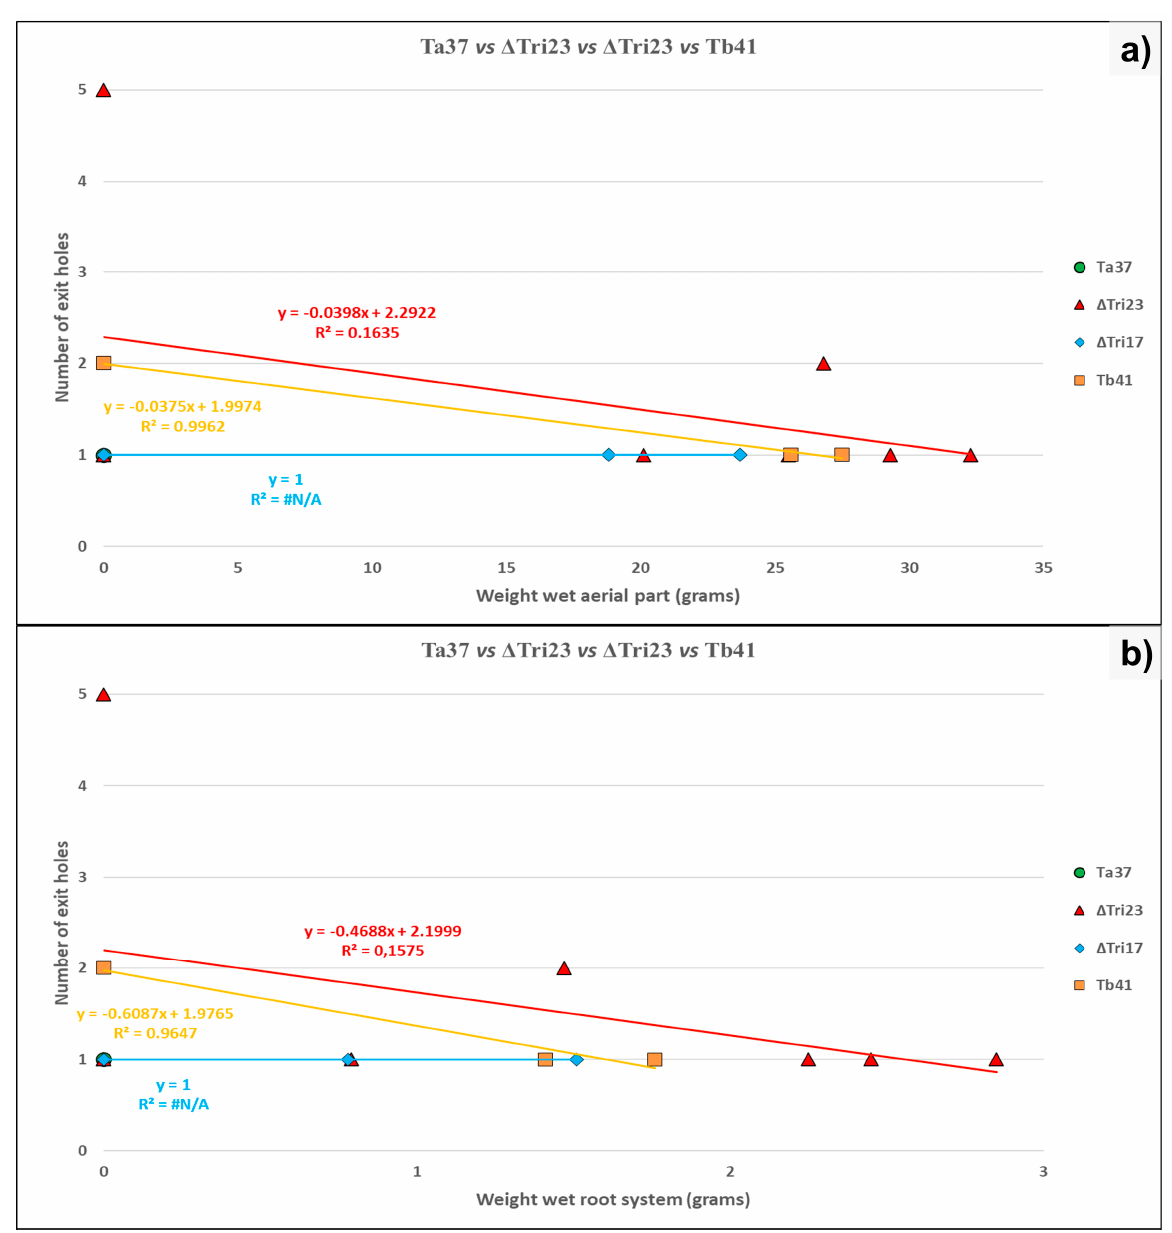
Figure 6. ( a ) Linear regression of wet weight aerial part (WWAP) of P. vulgaris plants ( x -axis) versus Number of Exit Hole (NEH) of P. vulgaris beans ( y -axis). ( b ) Linear regression of wet weight root system (WWRS) of P. vulgaris plants ( x -axis) versus number of exit holes (NEH) of P. vulgaris beans ( y -axis). “Round Green Point” means bean samples sprayed with Ta37. ’Triangular Red Point” means bean samples sprayed with ∆ tri23 . “Diamond-shaped Blue Point” means bean samples sprayed with ∆ tri17 . “Square Orange Point” means bean samples sprayed with Tb41. Linear regression trendlines are coloured based on the strain (“Green Line” represents Ta37 strain, ‘Red Line’ represents ∆ tri23 strain, ‘Blue Line’ represents ∆ tri17 strain, ‘Orange Line’ represents Tb41